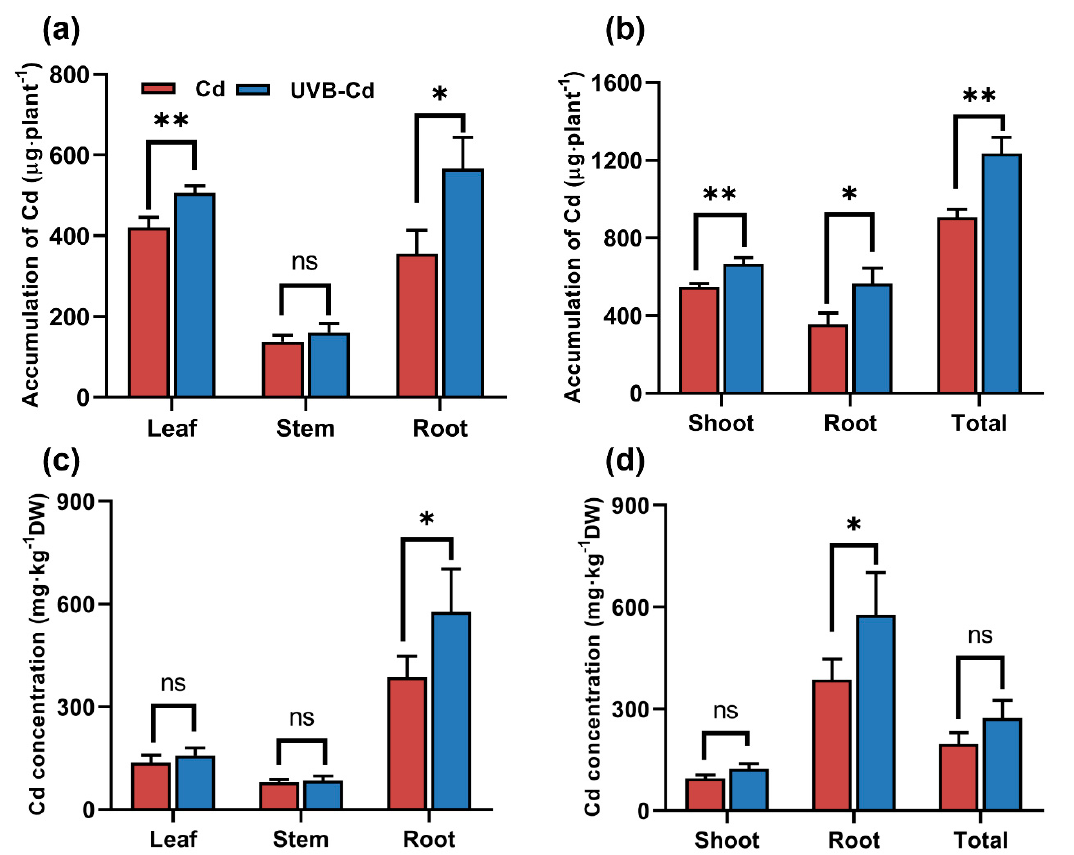
Figure 5. The total accumulation of Cd in different tissues ( a ) and the whole plant ( b ), and the Cd content in different tissues ( c ) and the whole plant ( d ) under different treatments ( n = 9 plants for each treatment). Asterisks represent significant differences between two treatment groups: * represents p < 0.05; ** represents p < 0.01.